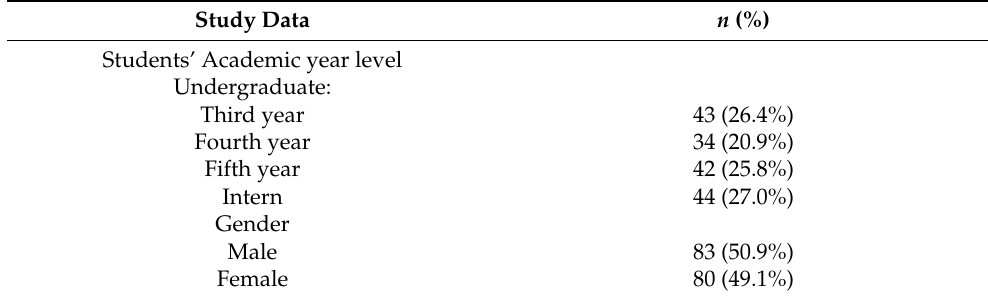
Table 1. Respondents’ distribution according to gender and academic year level of the dental students ( n =